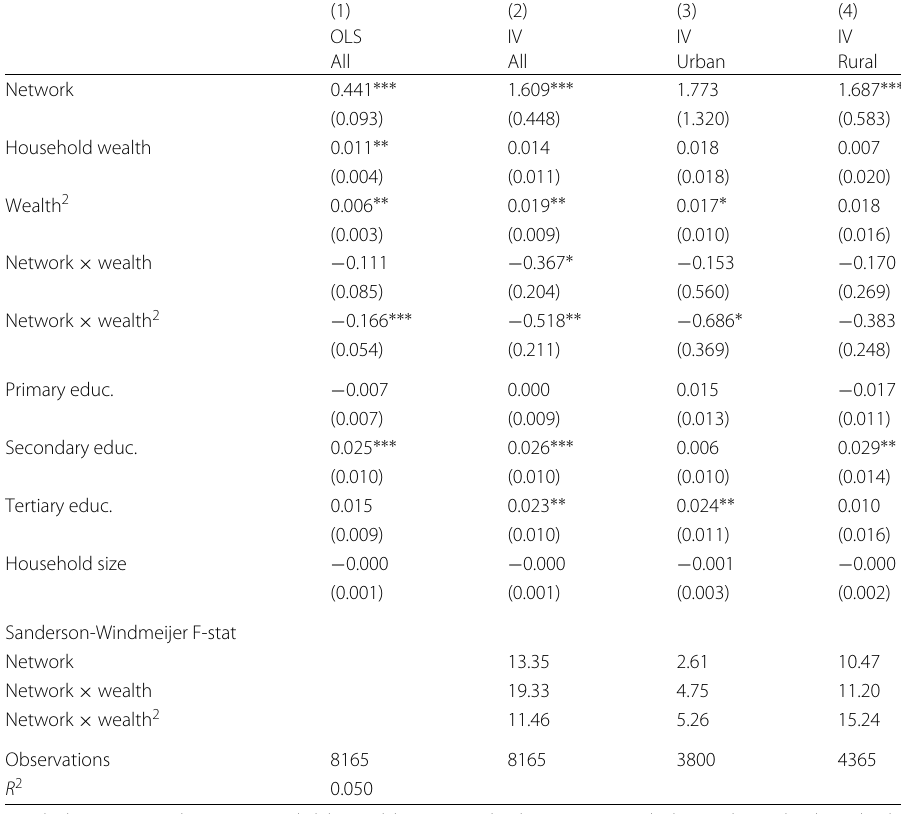
Table 6 Individual determinants of the emigration decision (1) (2) (3) (4) OLS IV IV IV All All Urban Rural Network 0.441 ∗∗∗